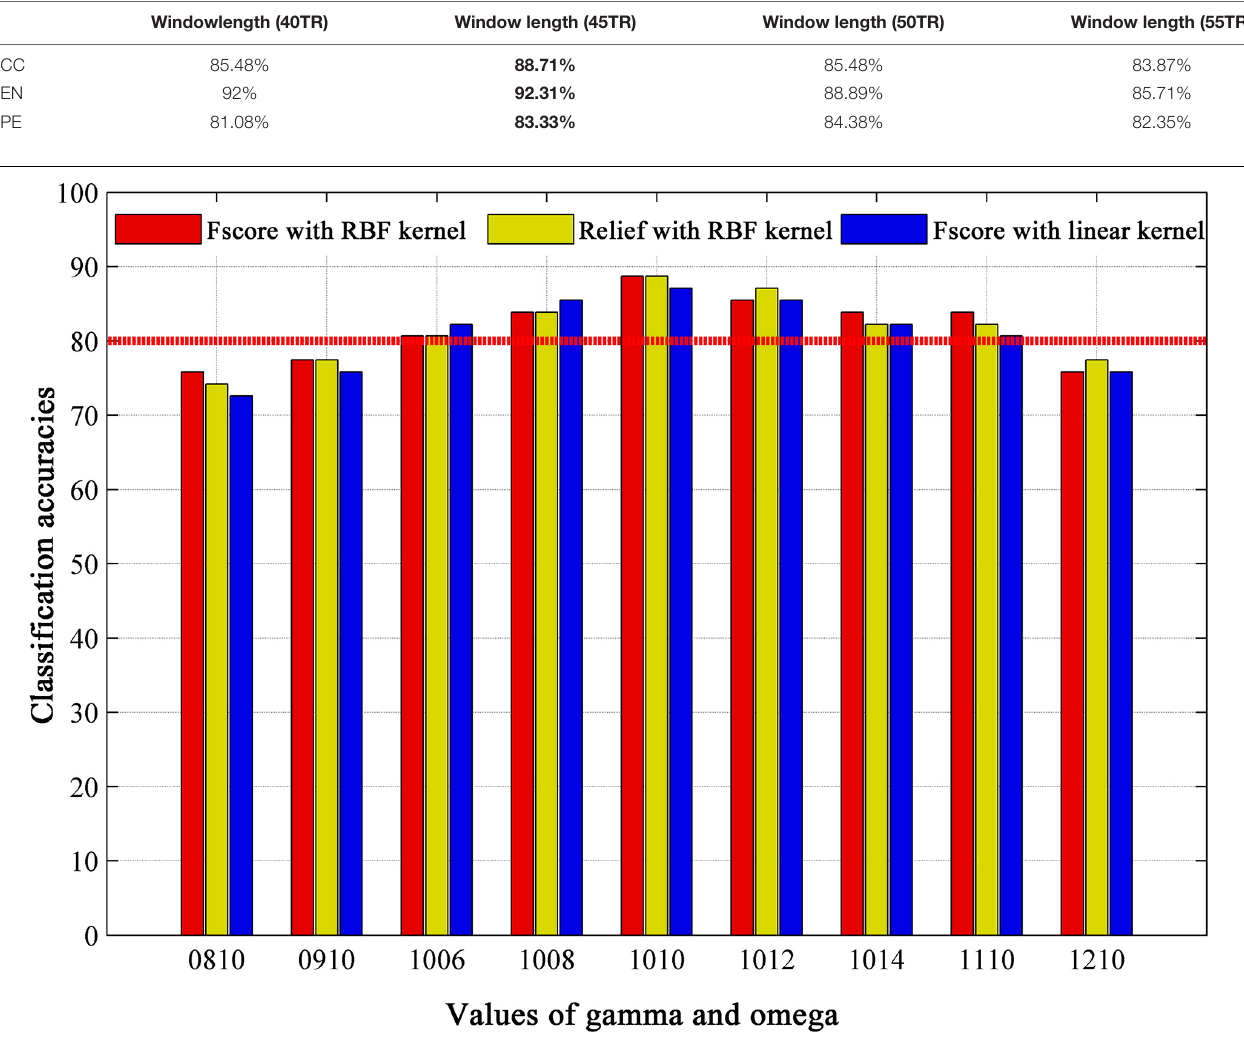
FIGURE 5 | The classification results based on different module partition parameters (gamma, omega), feature selection methods (Fscore and Relief), and kernel functions of classifier (RBF kernel and linear kernel), where omega is spatial resolution parameter, and gamma is temporal resolution parameter in multi-layer community structure calculation. Values of gamma and omega = 0810 mean gamma = 0.8, omega = 1.0. RBF = radial basis